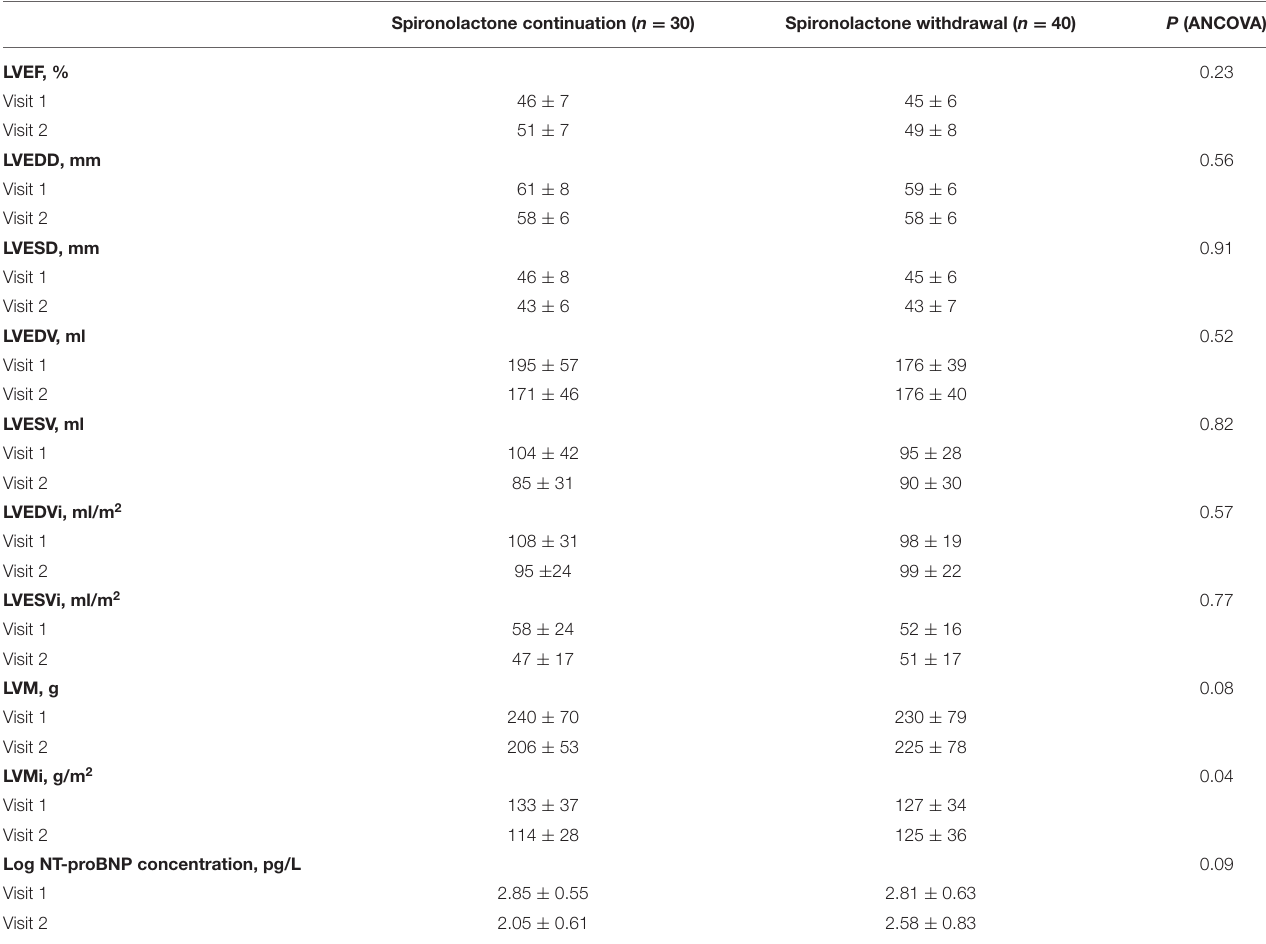
TABLE 3 | Echocardiographic parameters over a 1-year follow-up period. Spironolactone continuation ( n = 30) Spironolactone withdrawal ( n =